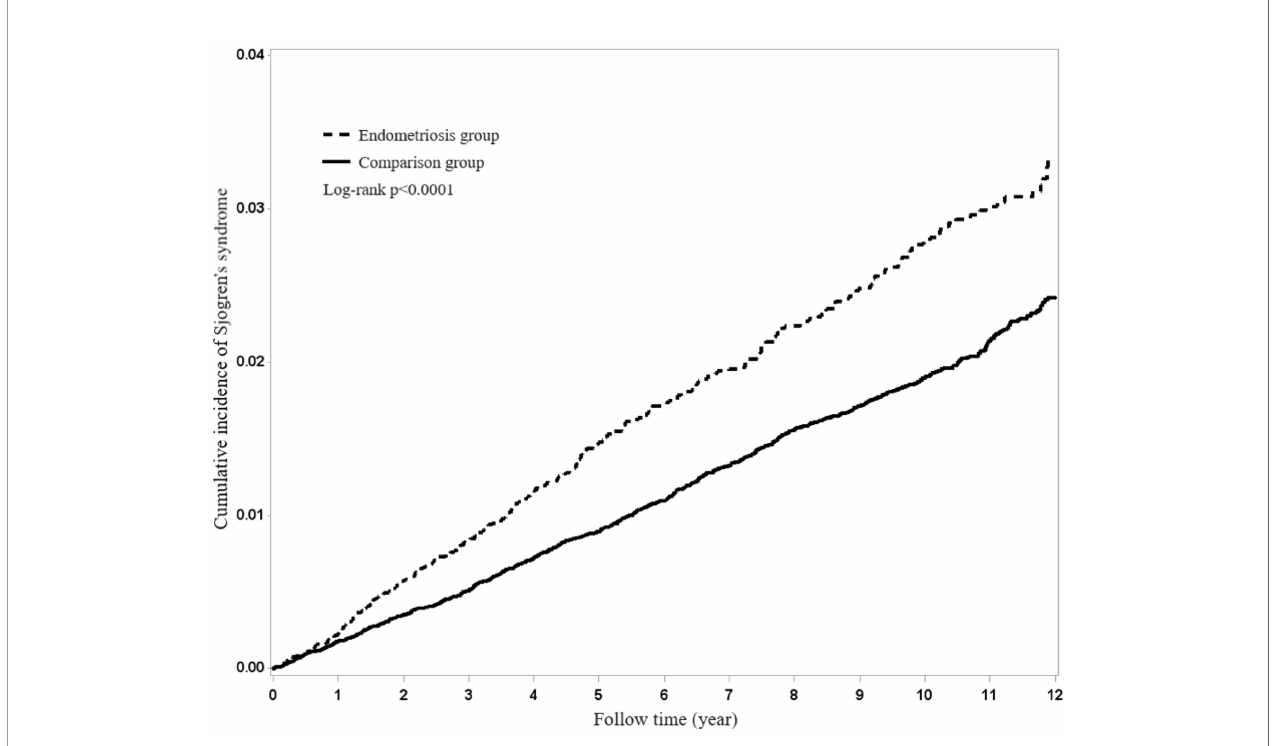
FIGURE 1 | Using Kaplan-Meier survival statistics, it showed crude overall survival curves by with and without endometriosis (log-rank P<0.0001).